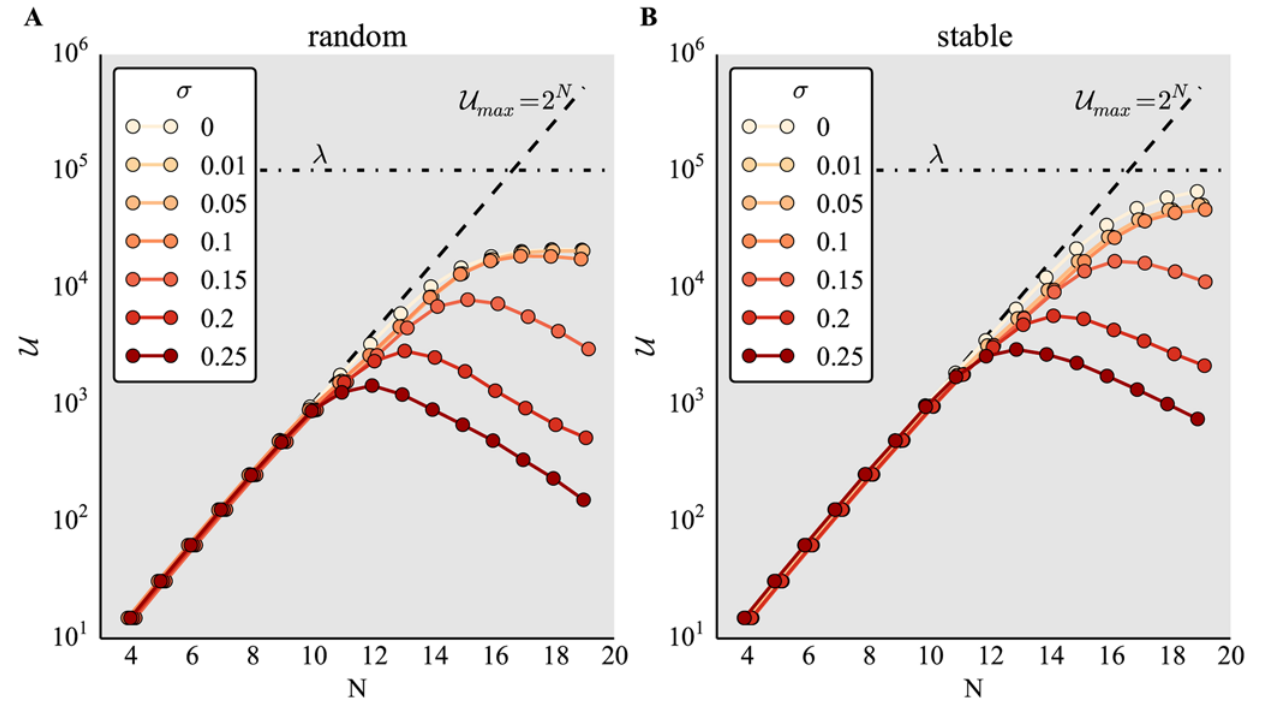
Fig 1. Noise is detrimental to phenotype discovery by binary networks with bimodal gene expression. Number of unique phenotypes U accessed for different network size N and varying degrees of noise σ , for (A) random networks and (B) networks pre-selected for stability. Networks are binary, W b , gene expression is bimodal, k = 2, s off = 0, maximum of T = 100 iterations, and sample size λ = 10 5 . Jitter was added to values on the x-axis to avoid overlap of markers. Horizontal dashed lines represent sample size λ = 10 5 . Diagonal dashed lines represent the size of phenotype space: U max = 2 N